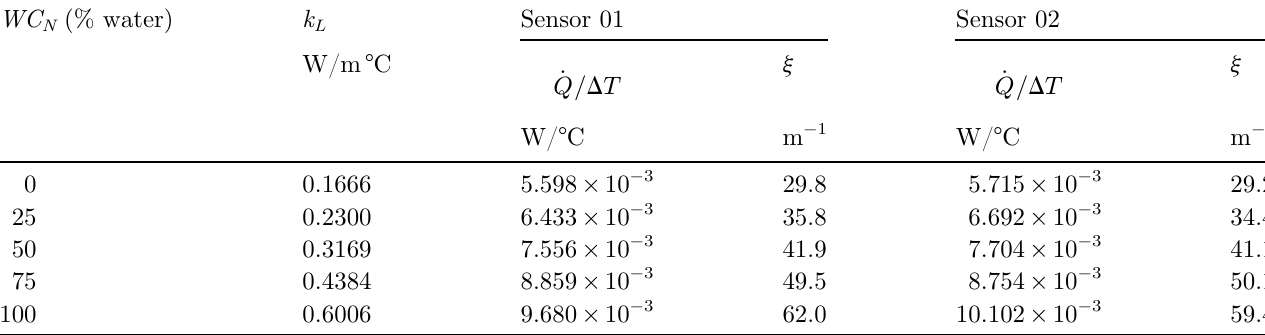
_ Q = D T and j for each sample obtained at 20 ° C.